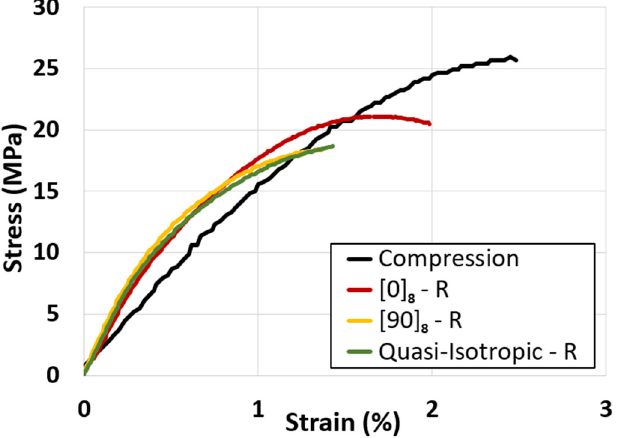
Figure 5. Representative tensile test of the post-processed lay-ups and compression-molded sample.